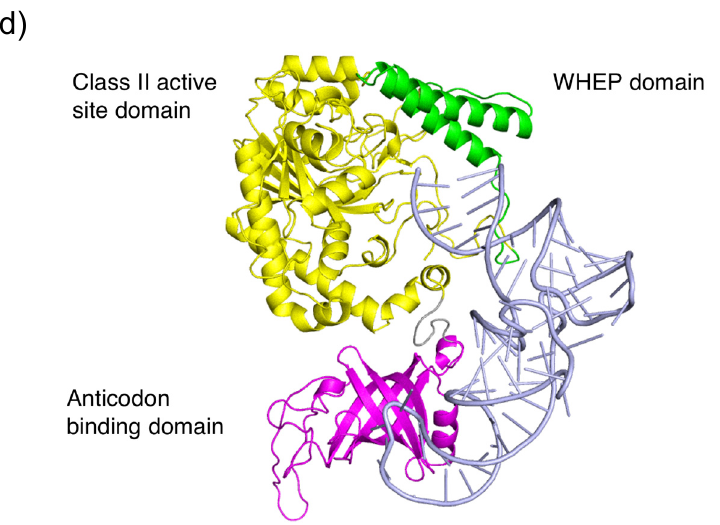
Figure 3. AsnRS from plants. ( a ) Schematic representation of the full-length AsnRS from various organisms. WHEP domain (green) is only seen inserted within a catalytic domain in plants. Three conserved motifs among class II aaRSs are shown. Motif 1 is located at the dimer interface while motifs 2 and 3 are located at the catalytic site. ( b ) Schematic representation of all the six AsnRS sequences in Arabidopsis. ( c ) Phylogenetic tree of AsnRS from plants. Green-colored boxes indicate those containing a WHEP domain. Black boxes indicate those containing mitochondrial (mTP) or chloroplast transit peptide (cTP) sequences, and hence are organellar forms. Sequences from di ff erent taxonomy are colored di ff erently. ( d ) Molecluar modeling of Arabidopsis AsnRS (SYNC3). Structures of AsnRS from P. horikoshii (1X54) and a WHEP domain from human TrpRS (1R6T) were used as templates to build SYNC3 structure. Structure of AspRS bound with tRNA (1EFW) was used as a template for modeling bound tRNA. Each domain is colored differently.